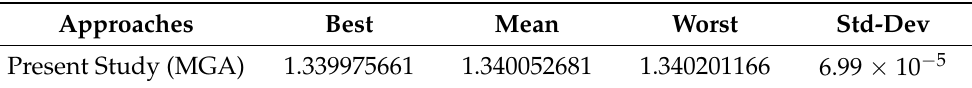
Table 28. Statistical results of the MGA method for the cantilever beam design problem. Approaches